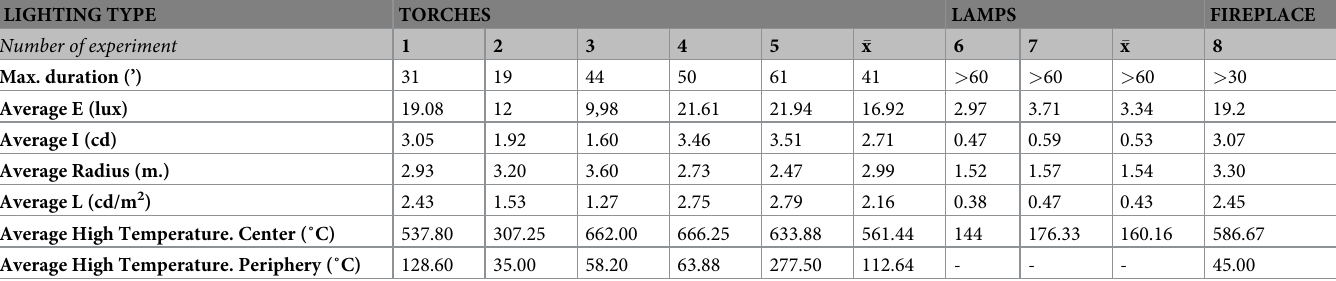
Table 1. Average values of the measured parameters in each